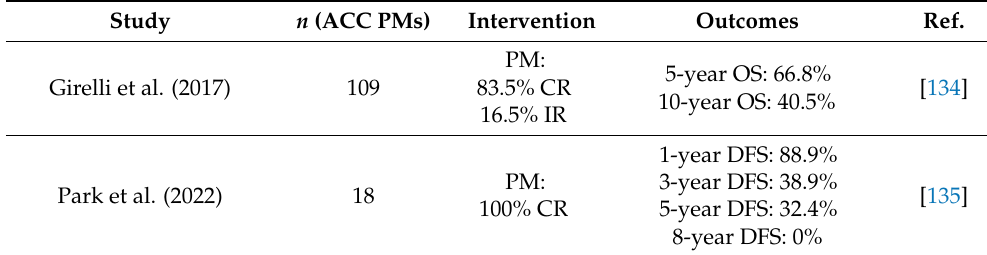
Table 1. Studies investigating pulmonary metastasectomy in